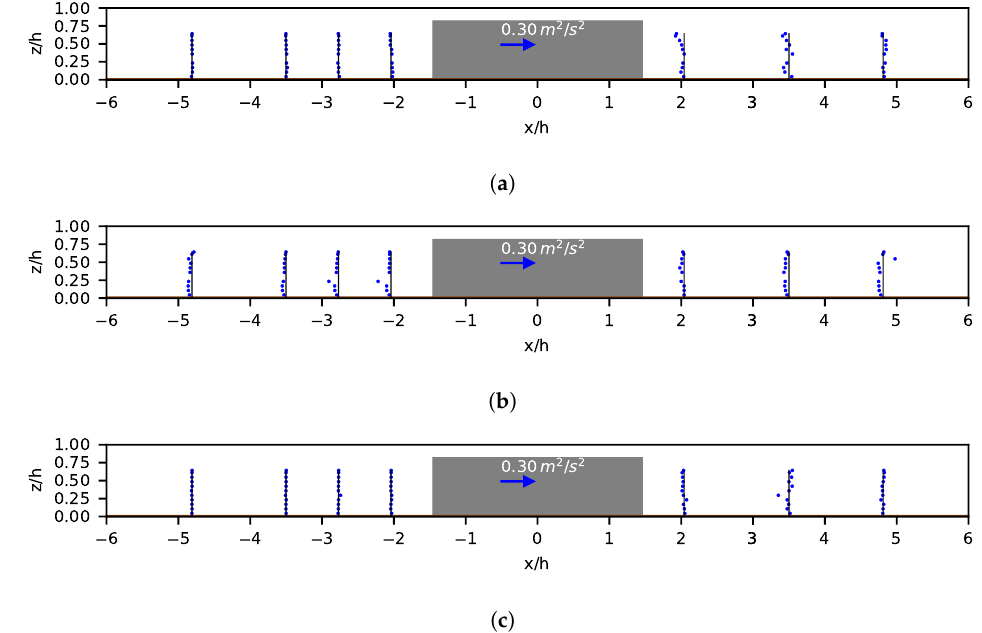
Figure 14. Vertical profiles of the Reynolds shear stresses along the pier’s mid-plane for Exp . 1 D Fbed . ( a ) Reynolds shear stresses ( u (cid:48) v (cid:48) ). ( b ) Reynolds shear stresses ( u (cid:48) w (cid:48) ). ( c ) Reynolds shear stresses ( v (cid:48) w (cid:48)